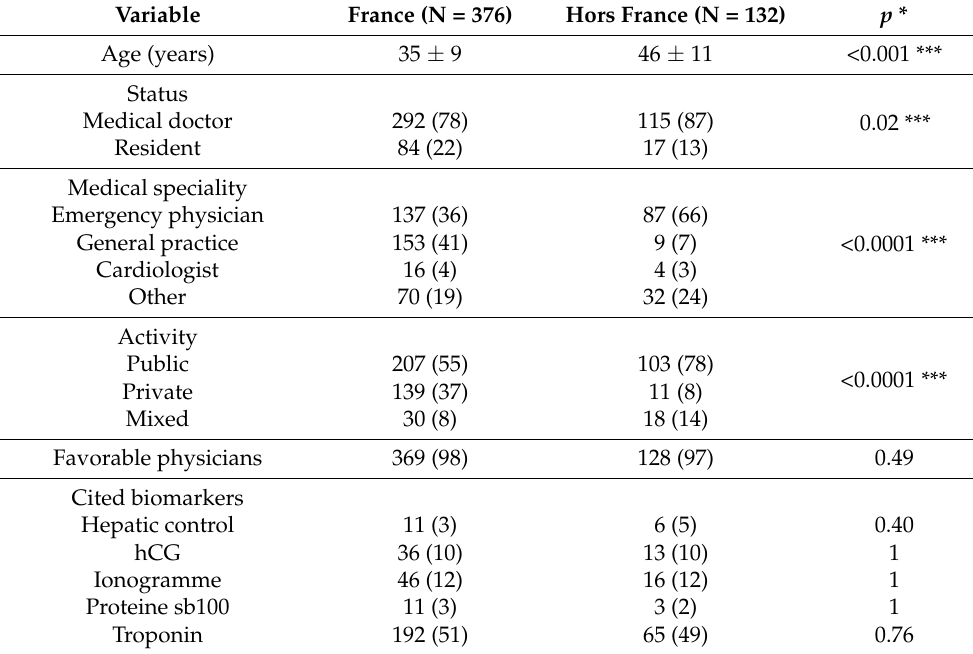
Table A2. France versus world